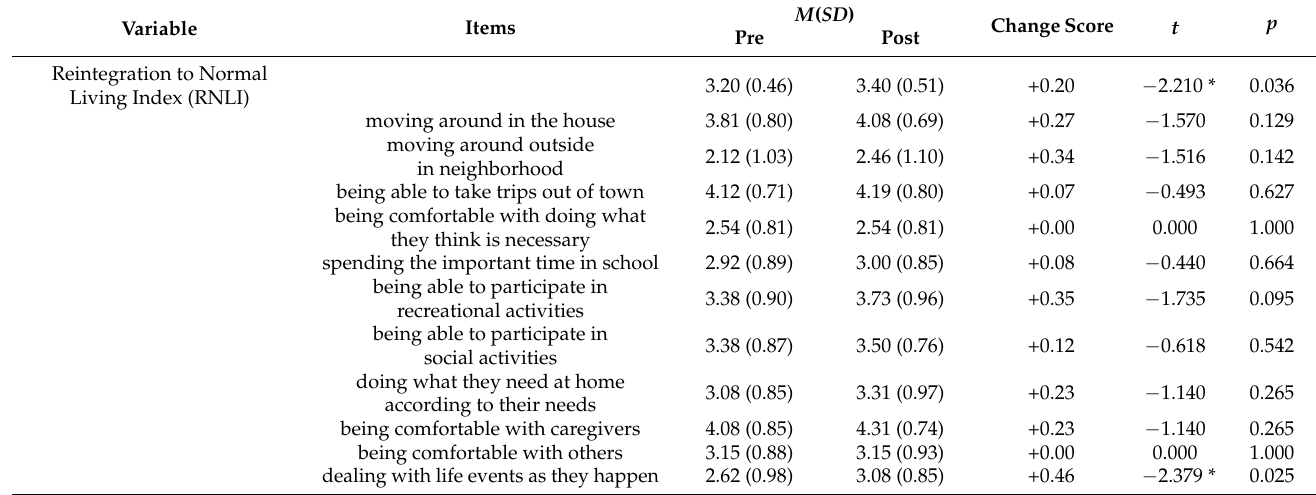
Table 2. Comparison of the RNL between before and after exercise program